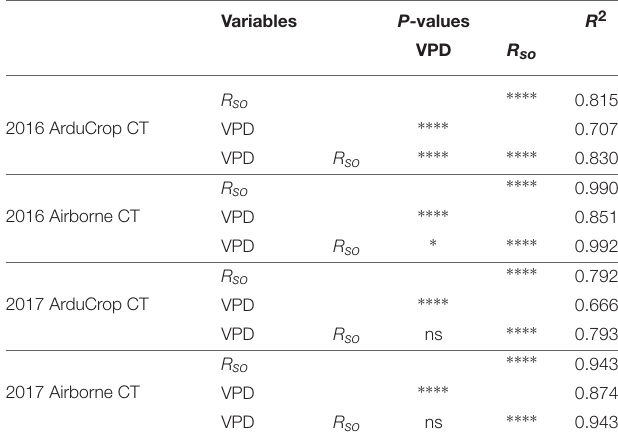
TABLE 2 | Ordinary least squares model results for canopy temperature (CT) repeatability (response variable) and the weather (explanatory) variables most significantly and strongly correlated with repeatability, namely R so and VPD (positive associations always).